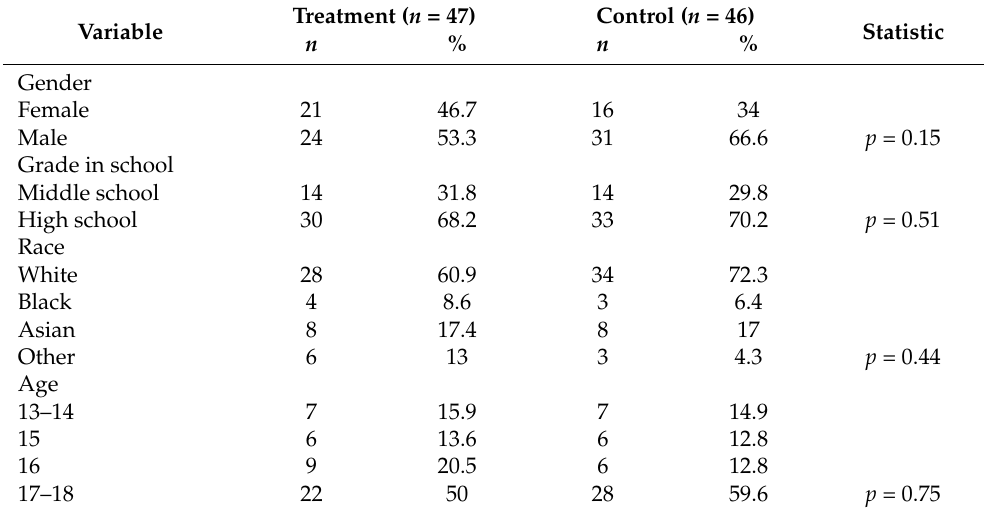
Table 3. Selected characteristics of the youth participants ( N =